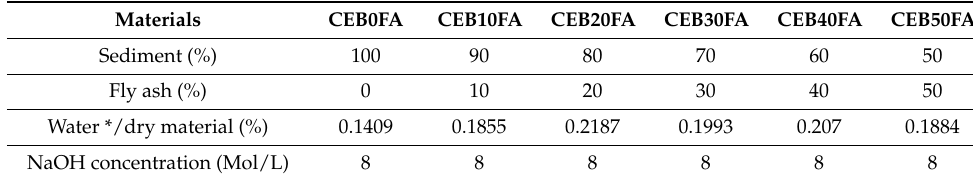
Table 4. Composition of CEBs mix-designs.